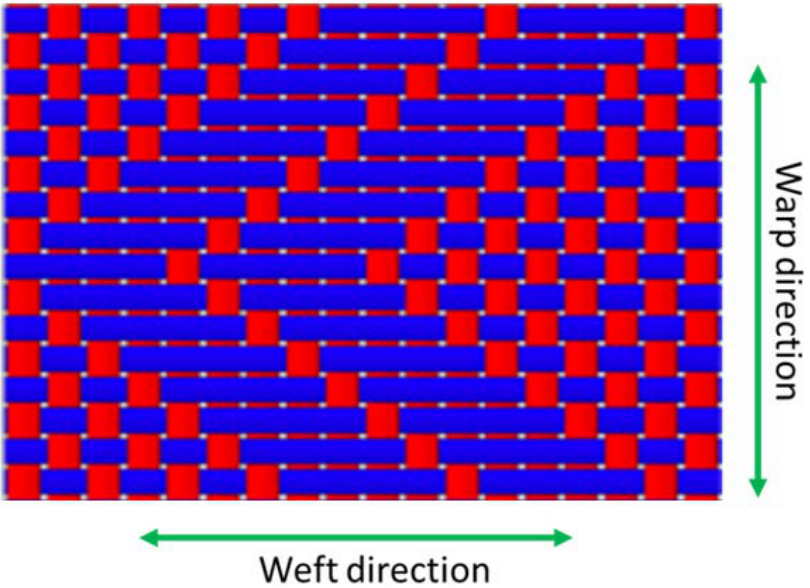
Figure 8. Texgen weave design for the auxetic structure.